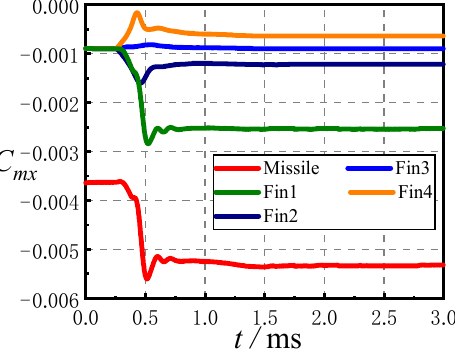
Figure 14. Variation of rolling moment coefficient of different aerodynamic components with time since lateral jet startup.